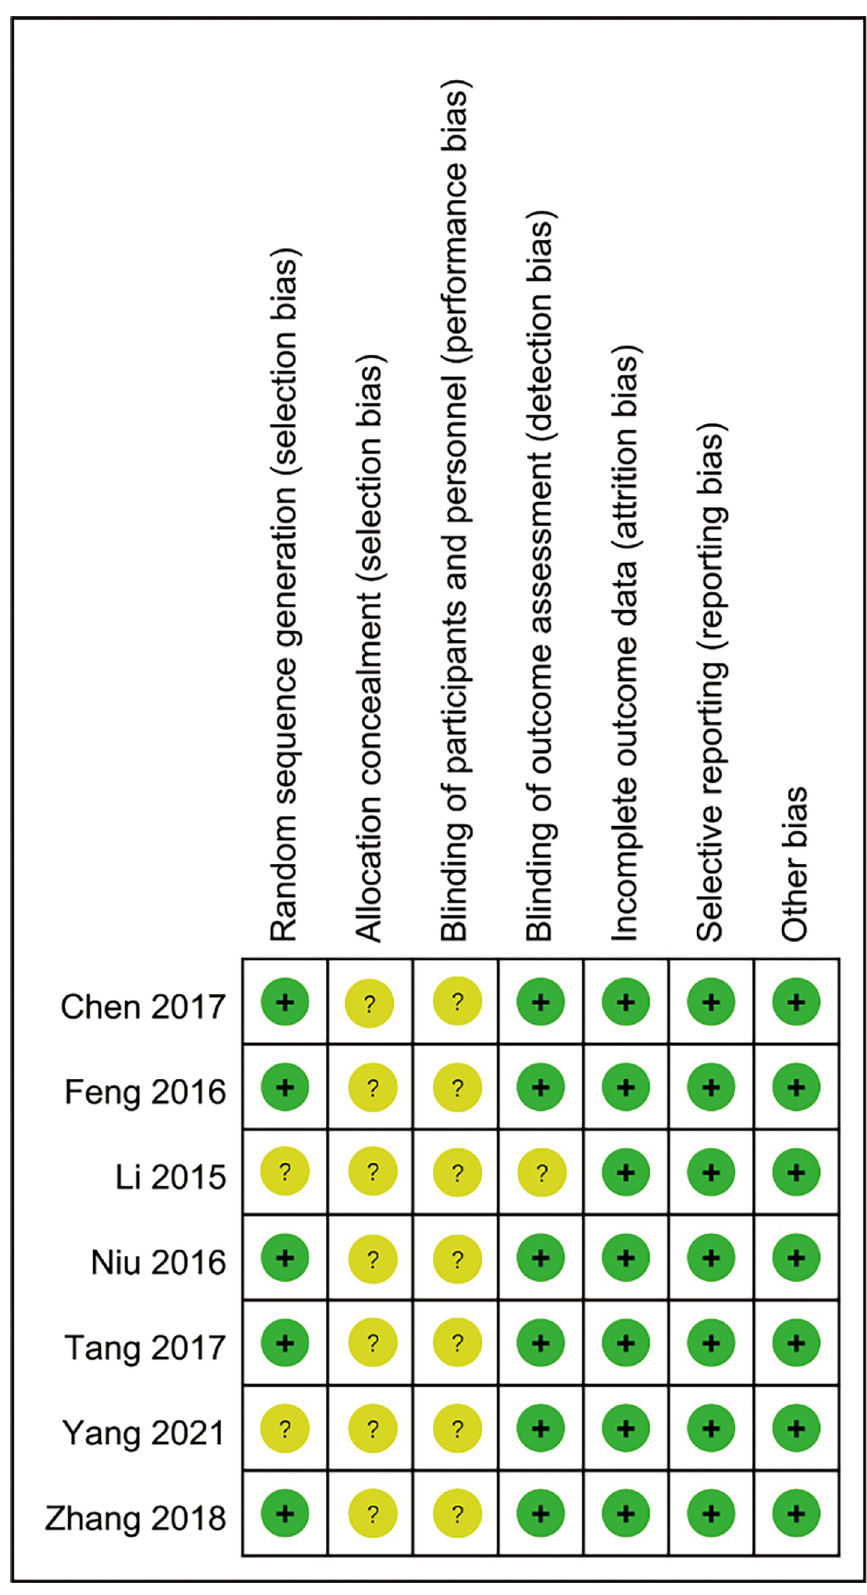
Fig 3. Risk of bias